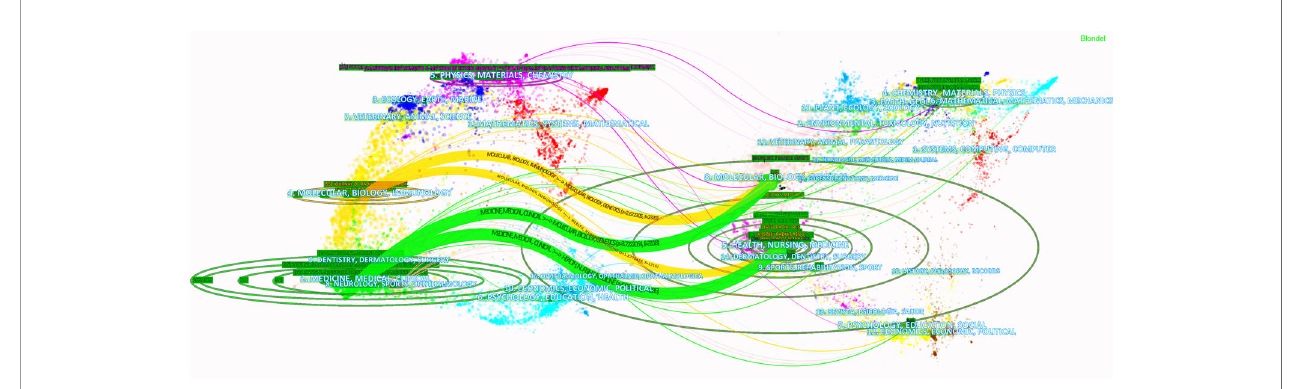
FIGURE 2 | Dual-map overlay of